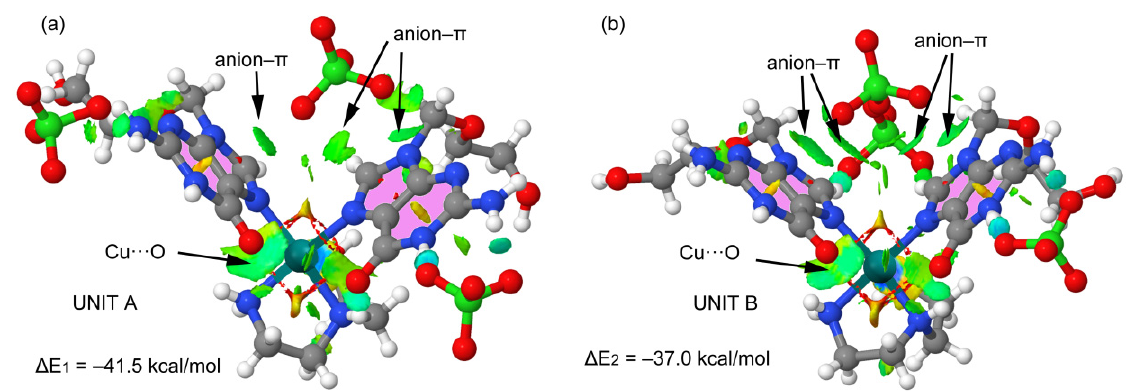
Figure 7. NCI surfaces of the anion– π complexes in units A ( a ) and B ( b ). The gradient cut-off is s = 0.35 au, and the color scale is − 0.04 < ρ < 0.04 au. The interactions energies at the B3LYP-D3/def2-SVP level of theory are also indicated. Atoms colour code: carbon—grey; hydrogen—white; nitrogen—blue; oxygen—red; copper—dark green, chlorine—light green.